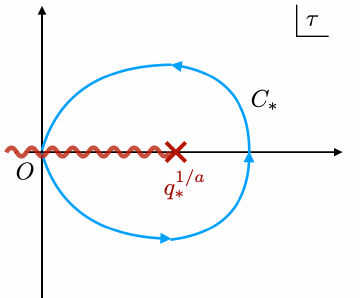
Figure 1 . Integration contour C ∗ . The branch cut, shown by the wavy line, stems from the Landau singularity of the running coupling constant. [ α s ( q ) diverges at q = q ∗